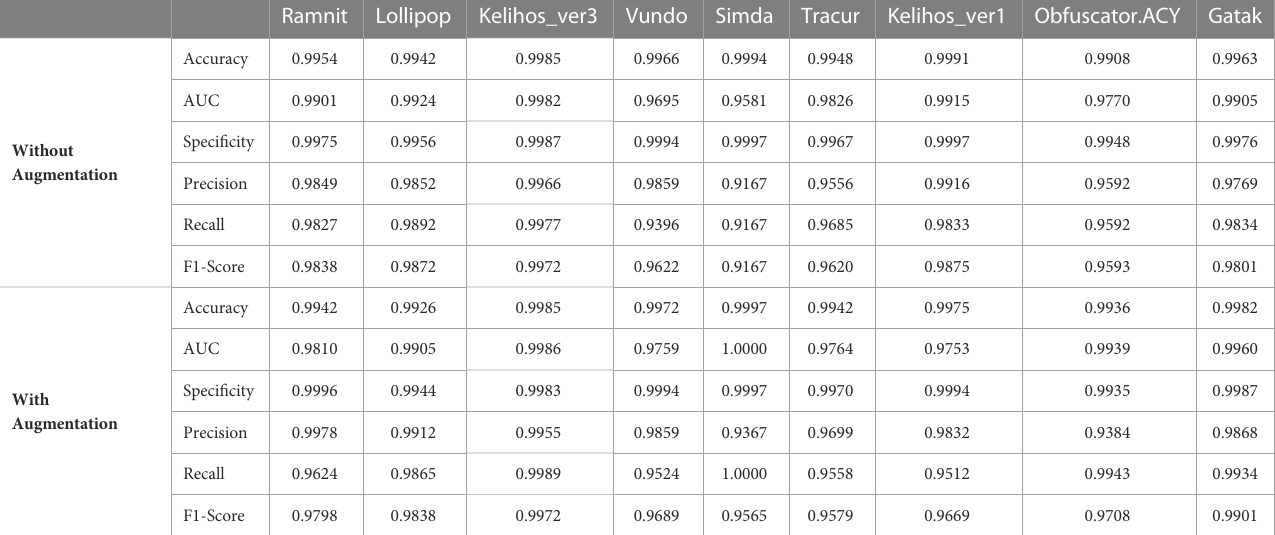
TABLE 3 Experimental results of gray images converted from BIG2015